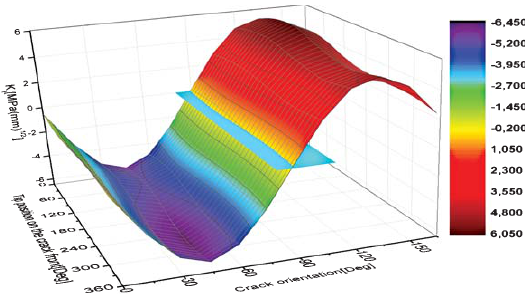
Fig. 13. K I distribution on the crack front as function of the crack orientation in the pos1 in cement mantle. Above the plane indicates the opening of the